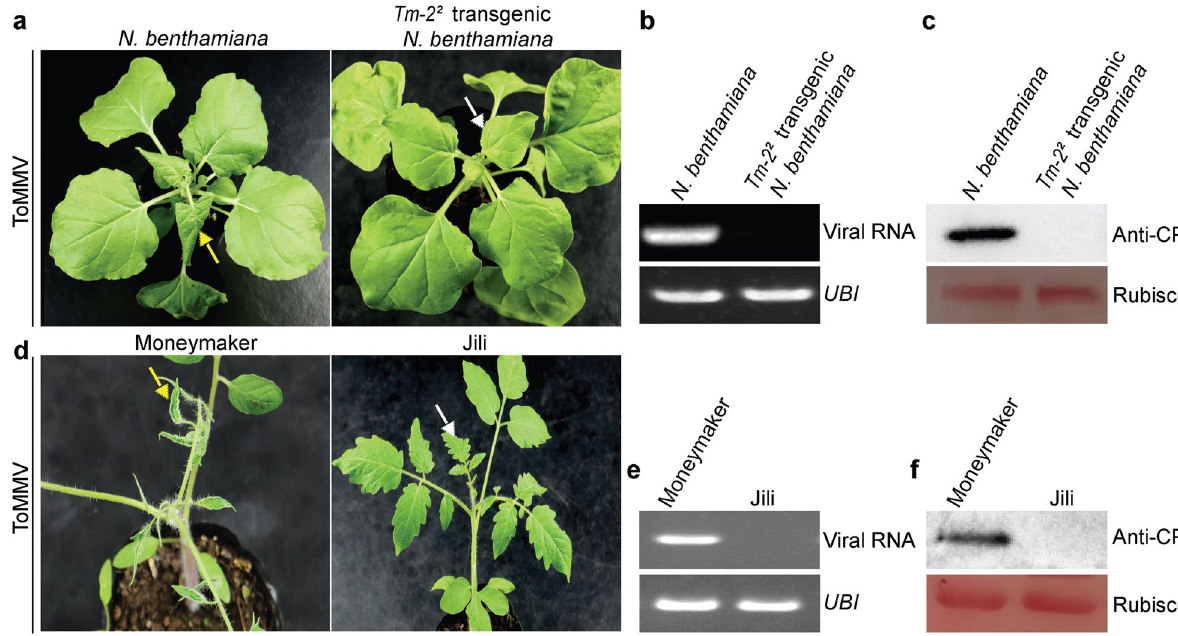
Fig. 1 Tm-2 2 ‑mediated resistance against ToMMV infection. a The symptoms of ToMMV‑inoculated wild‑type and Tm-2 2 transgenic Nicotiana benthamiana plants at 7 days post‑agro‑infiltration (dpai). b RT‑PCR detection of ToMMV RNA in systemic leaves of wild‑type and Tm-2 2 transgenic N. benthamiana plants. The ubiquitin ( UBI ) gene was used as an internal control. c Western blot analysis of ToMMV CP in the systemic leaves of the wild‑type and the Tm-2 2 transgenic N. benthamiana plants using CP antibody (anti‑CP). d The symptoms of ToMMV‑inoculated tomato cultivars Moneymaker and Jili at 14 dpai. e RT‑PCR detection of ToMMV RNA in systemic leaves of tomato cultivars Moneymaker and Jili. f Western blot analysis of ToMMV CP in the systemic leaves of tomato cultivars Moneymaker and Jili. Yellow arrows show symptomatic systemic leaves and white arrows show asymptomatic systemic